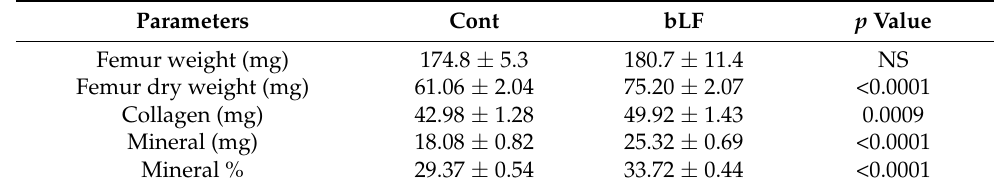
Figure 5. Effects of bLF supplementation on pup bone mineral density (BMD) and bone markers. Pups were recovered from mothers receiving the control diet (Cont) or the bLF-supplemented diet (bLF). ( A ) Whole body BMD. ( B ) Femoral BMD. ( C ) Vertebral BMD. ( D ) Plasma marker of bone resorption CTX. ( E ) Plasma marker of bone formation PINP. ( F ) PINP/CTX ratio. Data presented are means ± SEM (*** p < 0.001, **** p < 0.0001; n = 16 per group). The control and lactoferrin groups were compared by an unpaired two-tailed Student’s t -test. Table 6. Bone markers in pups recovered from mothers receiving the control diet or the bLF- supplemented diet. The parameters were determined at postnatal day 17.